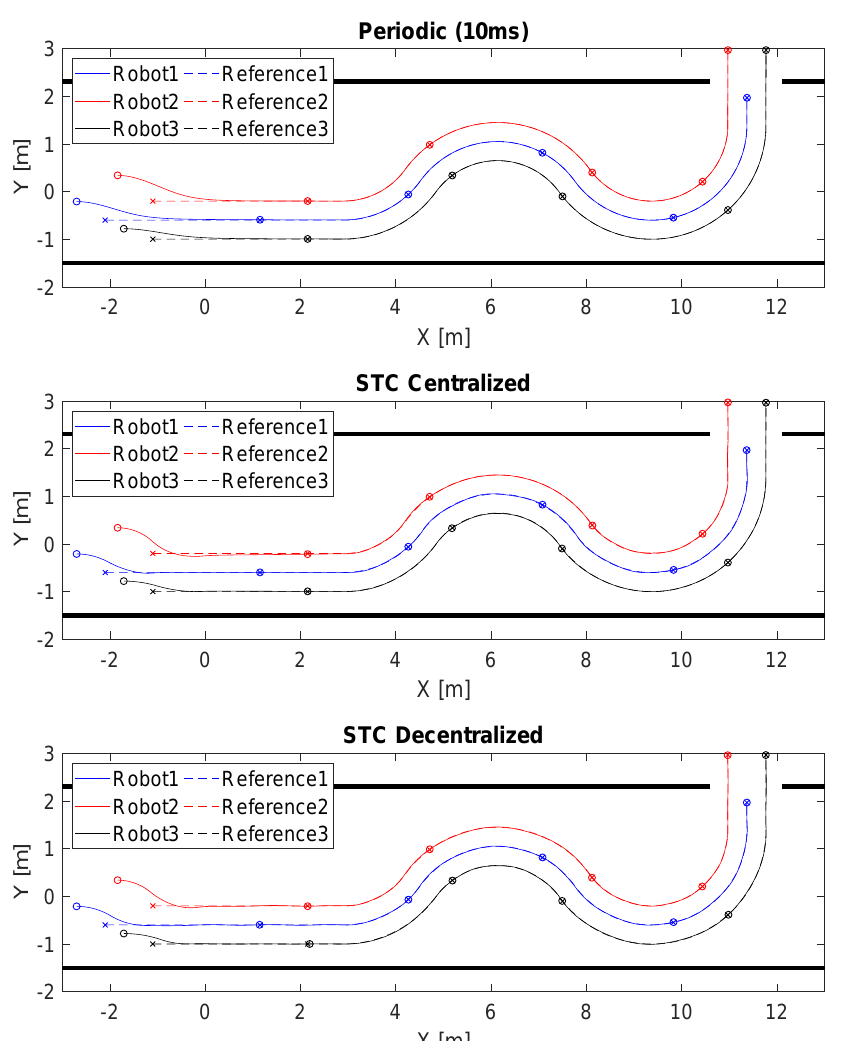
Figure 4. Nonlinear trajectory tracked by the formation of three robotic units. Robot 1 is represented in blue, Robot 2 in red and Robot 3 in black. The route followed by each robot is presented with a continuous line, the reference with a discontinuous line, and every 13 s the punctual position of each of them is shown with a circle and an x, respectively. The top figure represents the periodic implementation, the middle one the STC with centralized triggering (26) and the bottom the STC with decentralized triggering